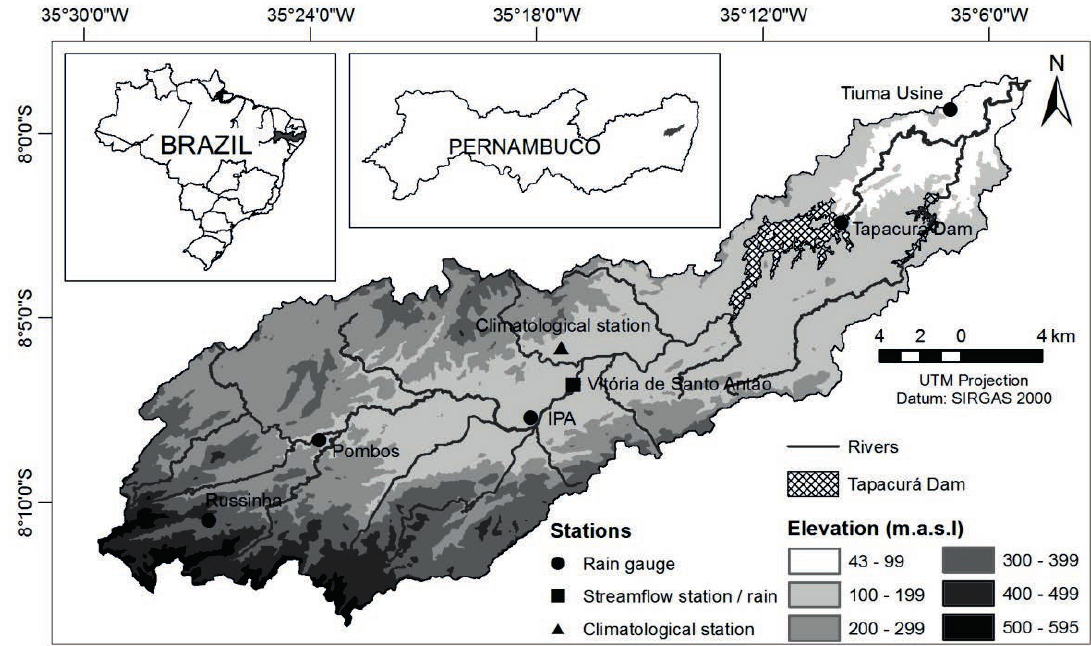
Fig. 1 Location of Tapacurá catchment in Brazil and the rainfall, streamflow and climatological